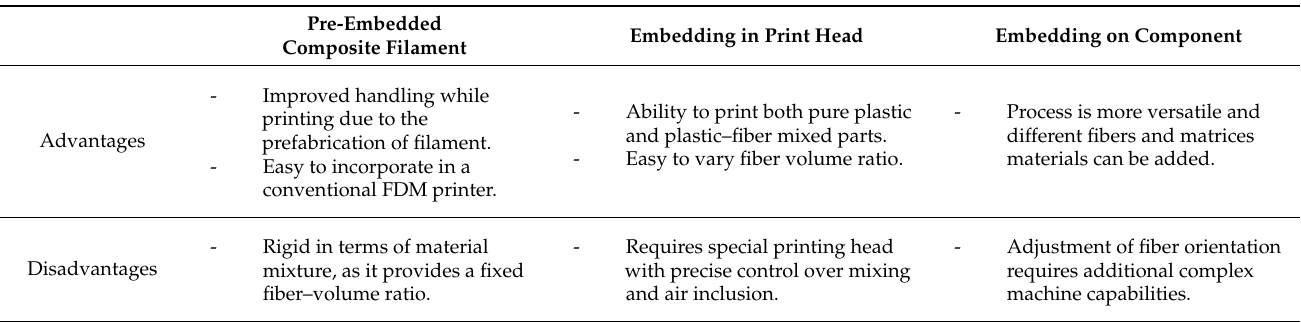
Figure 14. Schematic illustration of the second FRP printing strategy using continuous fibers and polymer (redrawn from [59]). Table 2. 3D printing method.